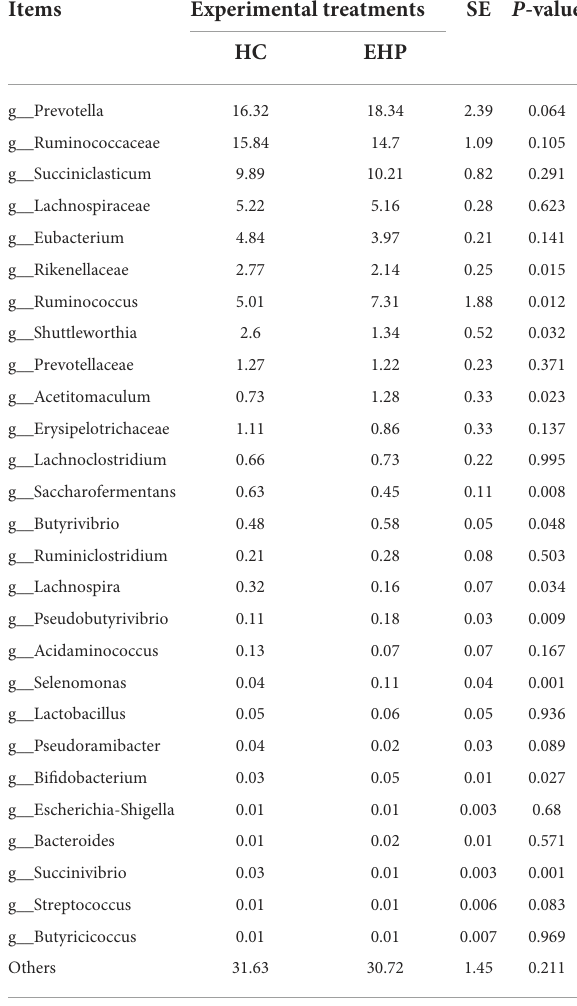
TABLE 6 Effects of small peptide supplement in high-concentrate diets on relative abundances of ruminal bacterial communities (%) (level of genera) ( n ,